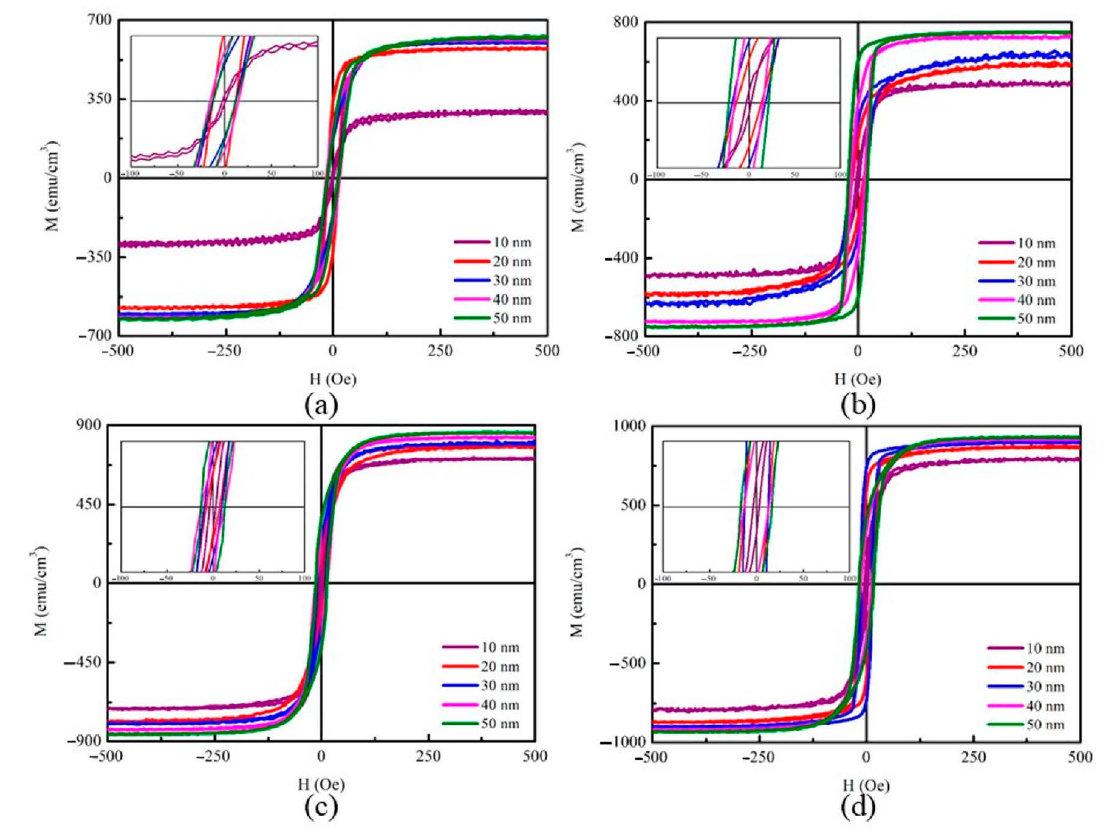
Figure 3. In-plane magnetic hysteresis loop of CoFeBY films. ( a ) RT, ( b ) after annealing at 100 ◦ C, ( c ) after annealing at 200 ◦ C, ( d ) after annealing at 300 ◦ C.